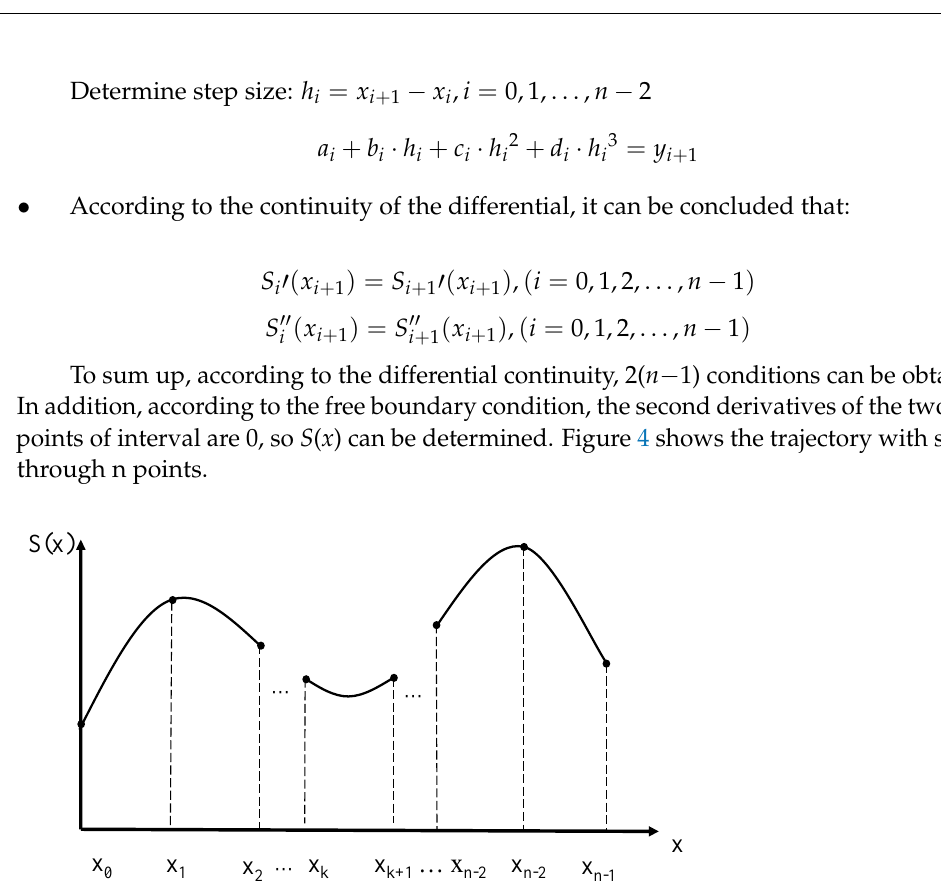
Figure 4. Trajectory with spline through n points.